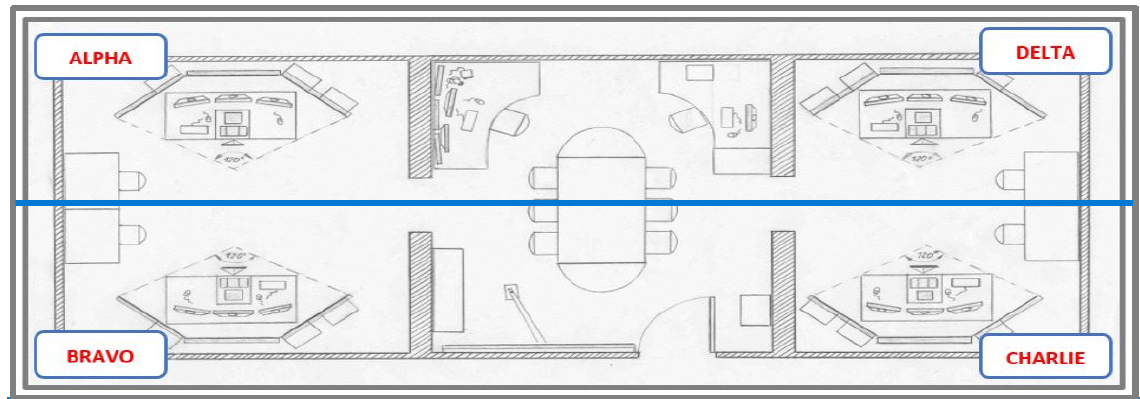
Figure 1. Schematic plan of the simulator components and navigation bridge layout. Source: Own